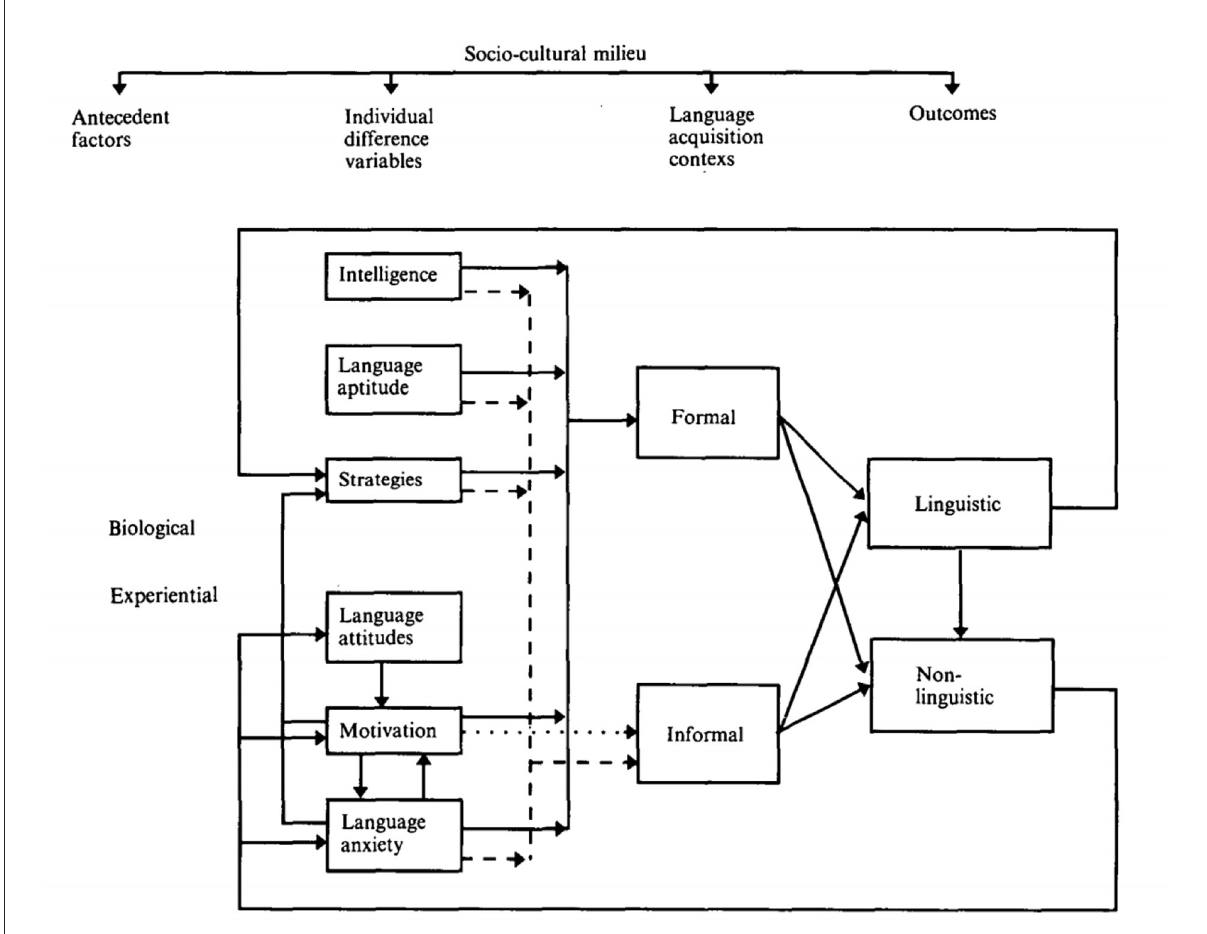
FIGURE1 Schematic representation of the Socio-educational Model of SLA (Gardner and MacIntyre, 1993b, p. 8).